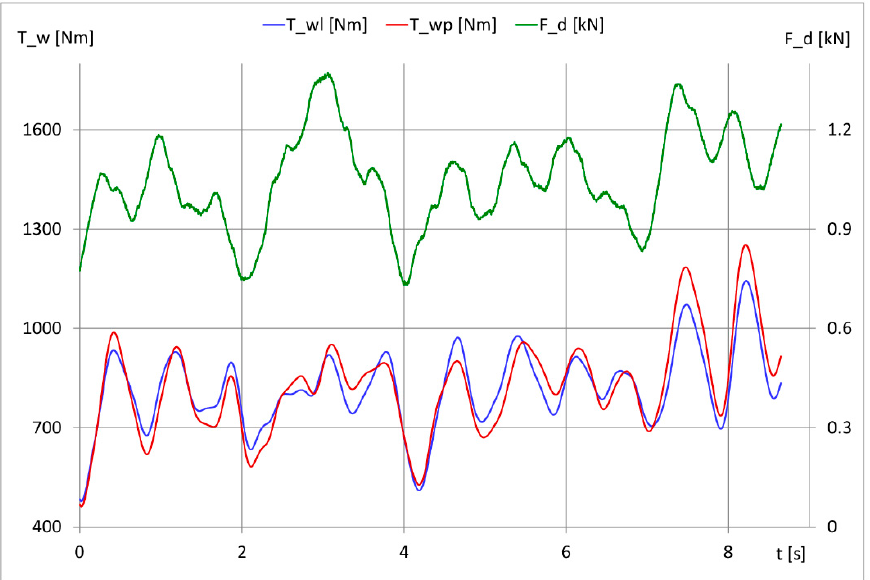
Figure 3. Changes in time of torques on wheels T w and drawbar pull F d ; soil profile—loamy sand, second gear, operating depth 0.09 m.